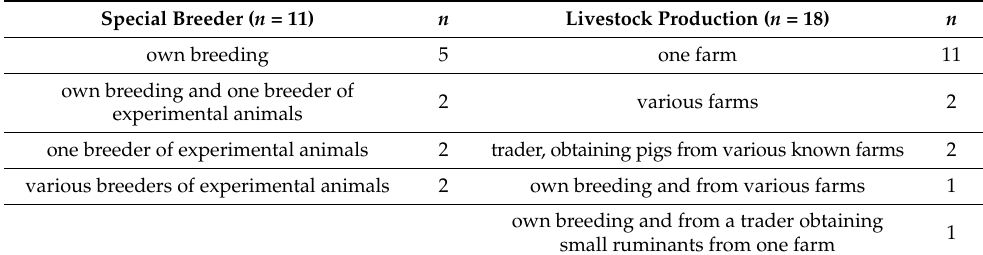
Table 4. Origin of small ruminants used for experimental